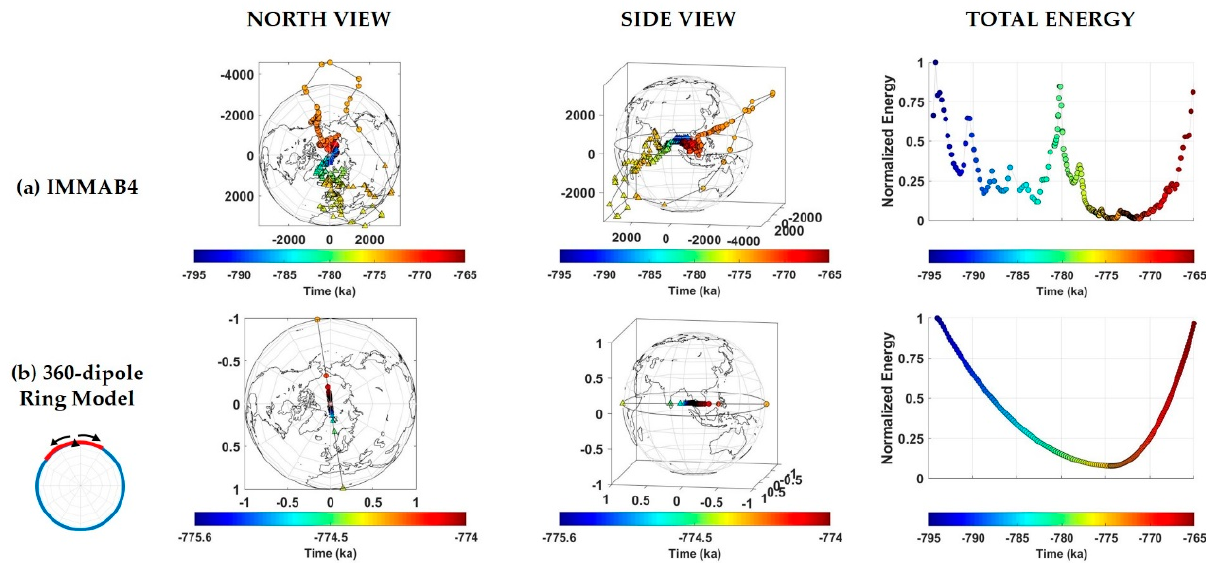
Figure 2. Evolution of the ED and the normalized total energy for the Matuyama-Brunhes polarity reversal according to ( a ) IMMAB4 paleoreconstruction (position in km); and ( b ) the 360-DRM proposed in this paper (see Materials and Methods section). Blue/red circumference indicates the first dipoles to change their polarity (black triangle) and the propagation directions (black arrows). Note that in ( b ) the evolution of the ED position is dimensionless and it is presented for a shorter time interval (the color scale is different) to remark the direction of the displacement. Also note that the ED is virtually coincident with the origin before and after the selected shorter period (see Figure S1). Coastlines are plotted only for longitude reference (note they are projected on a sphere of arbitrary radius).